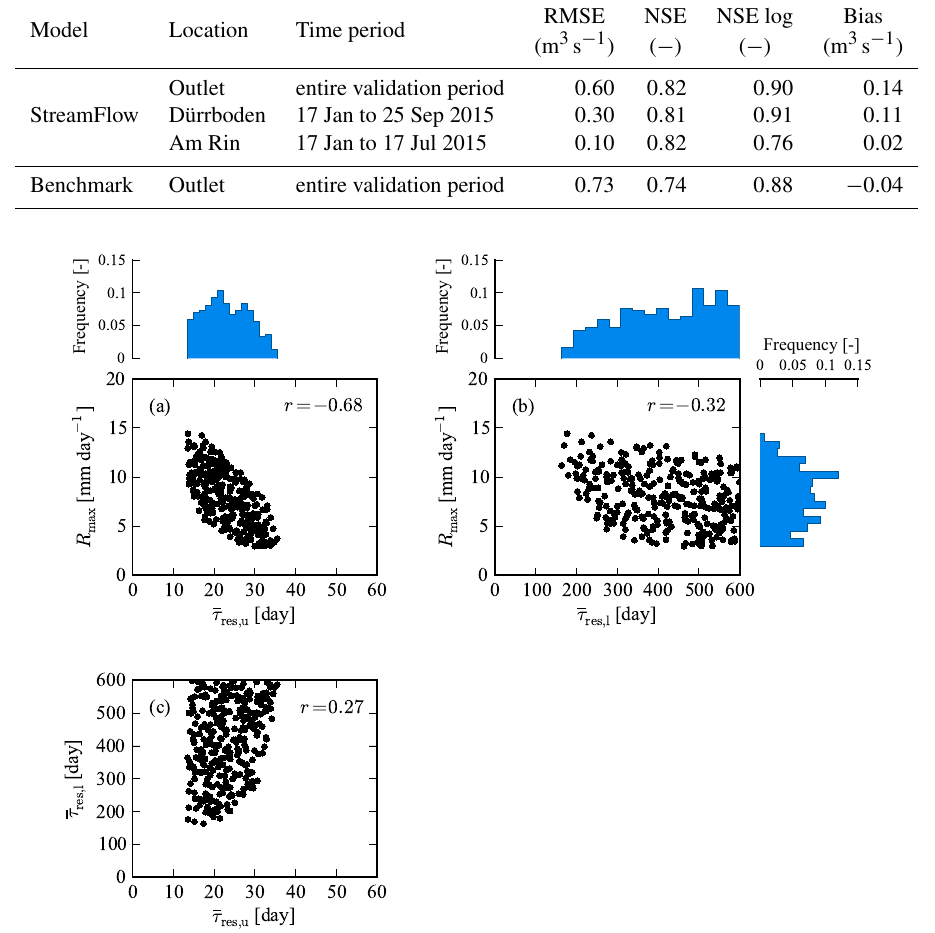
Figure 7. The 300 best sets of StreamFlow parameters associated with water transport (see Table 2 for more information on the parameters). Each panel contains the values of two parameters displayed as a function of each other: (a) R max versus τ res,l , (b) τ res,u versus τ res,l and (c) R max versus τ res,u . Each x or y axis spans the entire calibration range of its associated parameter. The parameter distributions are indicated in blue on the sides of the corresponding panels; for example, the distribution of the 300 best R max values is shown on the right-hand side of panel (a) . Pearson’s correlation coefficient r between each pair of parameters is indicated in the upper right-hand corner of the associated